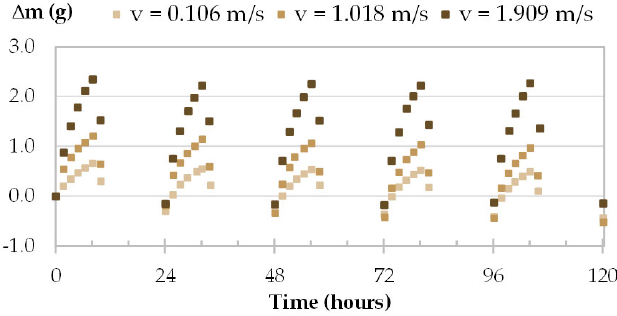
Figure 11. Moisture uptake and release kinetics for one specimen of FH (FH-c-4) in tests 1, 2 and 3.